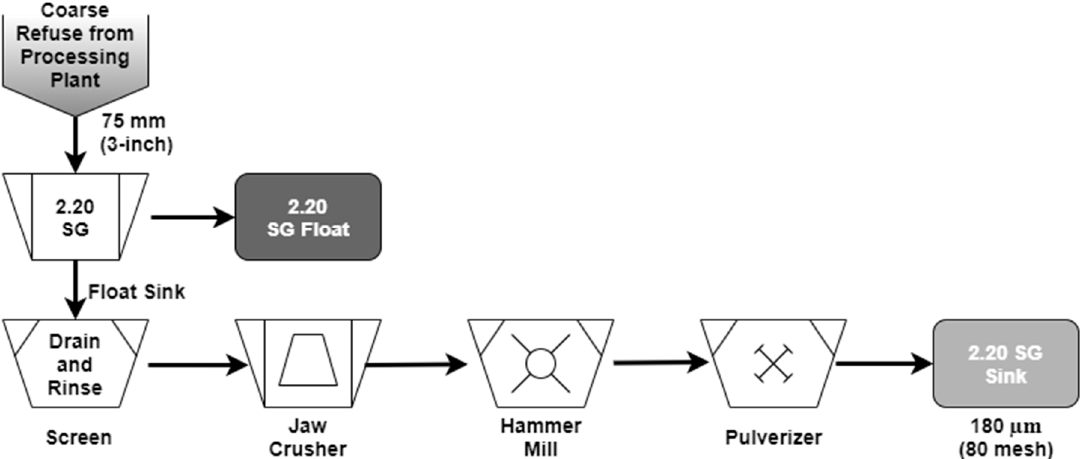
Figure 1. Process diagram of the sample preparation from the coarse refuse material collected from the processing plant treating Baker seam coal. Table 1. Rare earth element concentration (whole mass basis, ppm) in 2.20 SG sink fraction of Baker coarse refuse material [Ash Content: 91.0%].